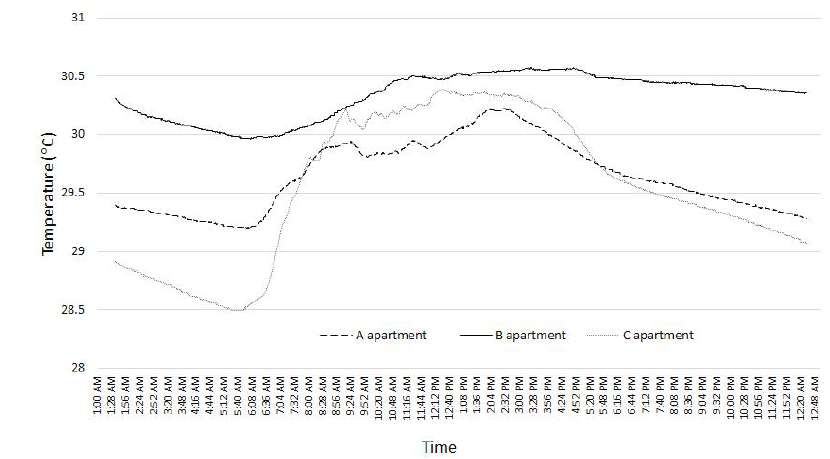
Fig. 16. Average indoor temperatures of 3×24 hours measurement